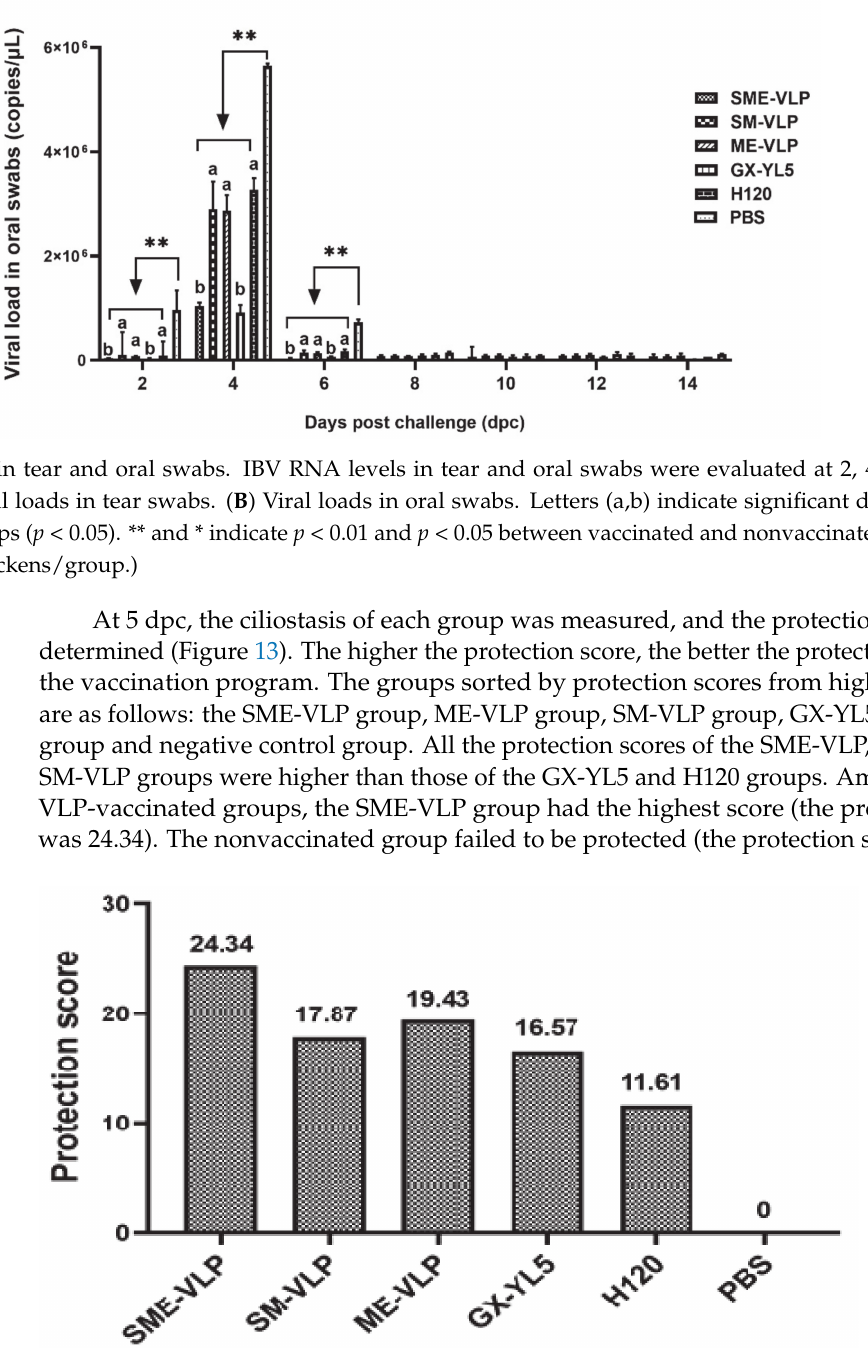
Figure 13. Ciliostasis protection scores for tracheas in challenged chickens at 5 dpc ( n = 10 chick-